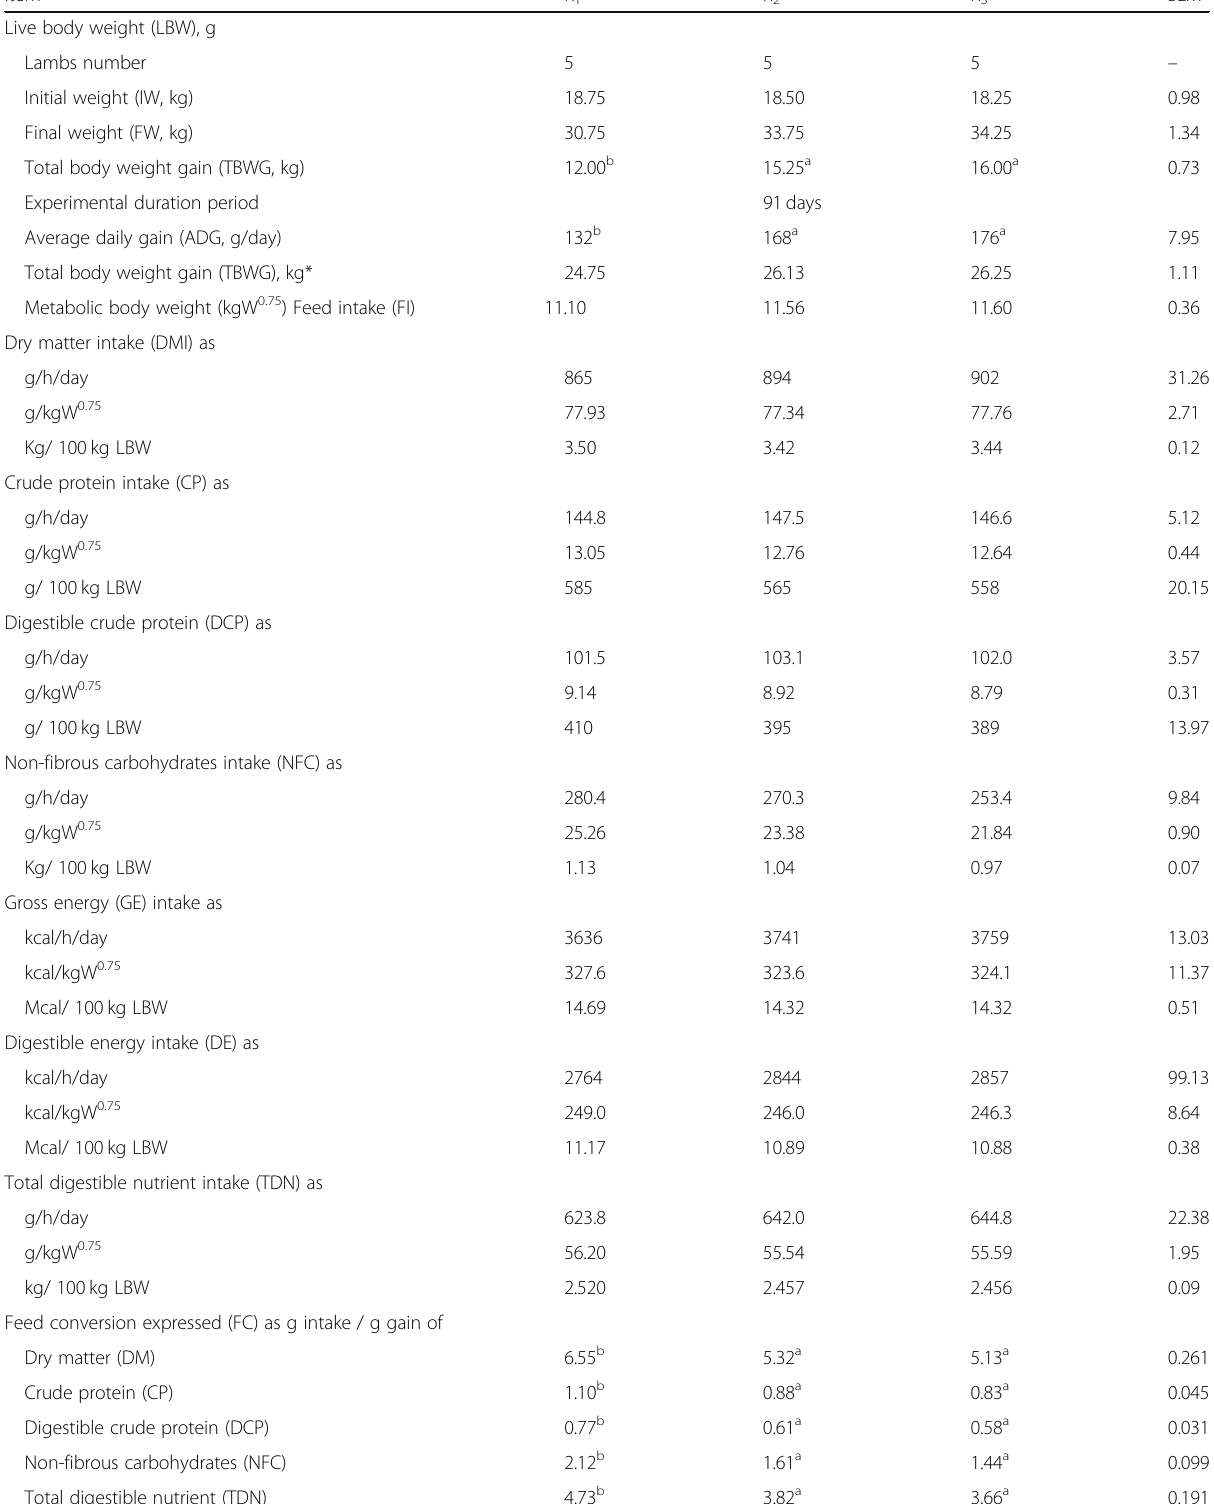
Table 4 Productive performance of the experimental